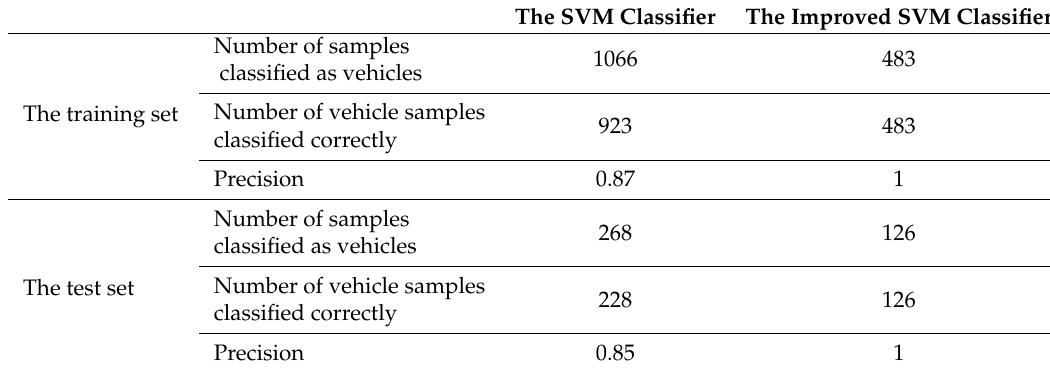
Table 3. Results of the SVM